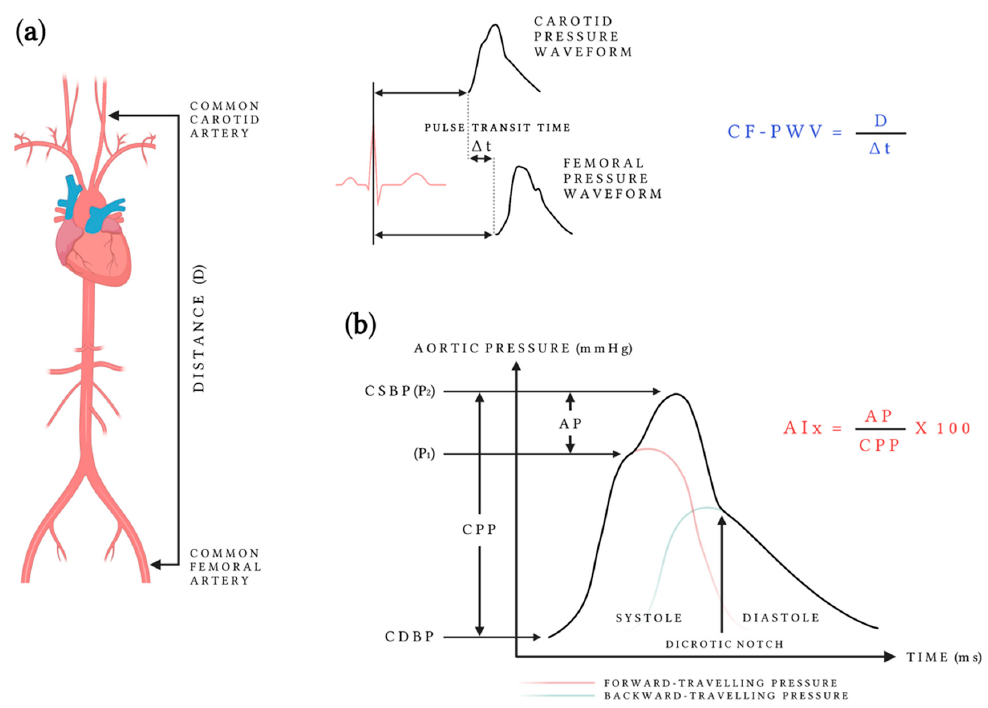
Figure 1. ( a ) Aortic pulse wave velocity measurement with applanation tonometry [28]: pulse transit time is measured from the foot of the carotid pressure waveform to that of the femoral pressure waveform using sequential recordings referenced to the electrocardiogram; the distance between the two recording sites is measured on the body surface and is calculated as the ratio of this distance to the pulse transit time; ( b ) the central aortic waveform is a composite of forward-traveling pressure created by ventricular contraction and backward-traveling pressure reflecting from vascular branch points or sites of impedance mismatch. The phenomenon of left ventricular late-systolic loading can be quantified using Aix—defined as the difference between the second (P2) and first (P1) systolic peaks of the central arterial waveform, expressed as the percentage of CPP [28]. Abbreviations: AIx, augmentation index; AP, augmentation pressure; CDBP, central diastolic blood pressure; cf-PWV, carotid–femoral pulse wave velocity; CPP, central pulse pressure; CSBP, central systolic blood